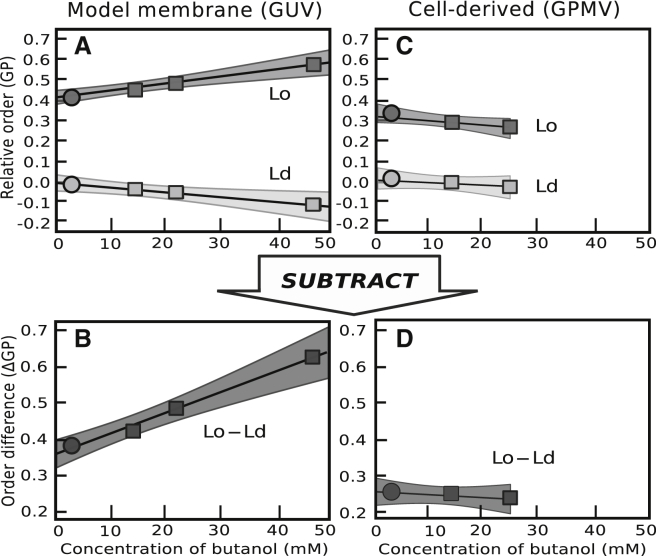
Differences between laurdan GP values in Lo and Ld phases in GUVs increase with butanol concentration in solution (A and B) and remain roughly constant in GPMVs (C and D). GUVs were composed of 35/35/30 DOPC/DPPC/cholesterol, and GPMVs were derived from RBL cells. Points represent average GP values for batches of 20–30 vesicles on different days. The slope of each line arises from a linear regression with fixed intercepts to offset untreated batch differences from day to day. Shaded areas are 95% confidence intervals of the fit. Slopes of the lines in (B and D) are 4.80 × 10−3 ± 1.37 × 10−3 and −6.81 × 10−4 ± 1.58 × 10−3, in normalized units of ΔGP/[(butanol concentration)(butanol’s membrane-water partition coefficient from (14))]. Fig. S5 and Table S1 contain corresponding data for GUVs and GPMVs with tetradecanol and hexadecanol.